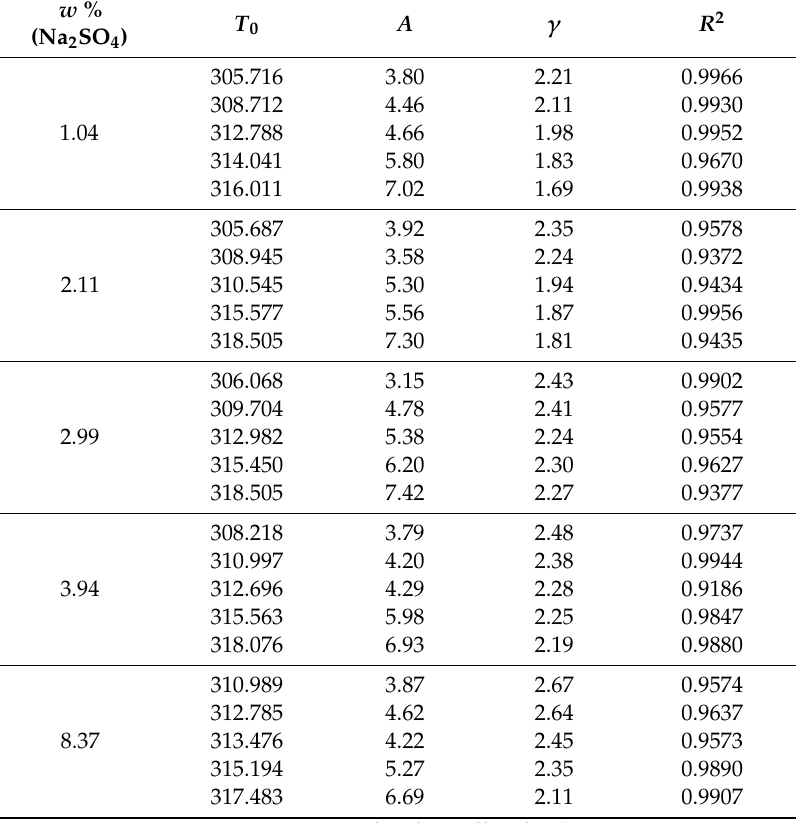
Table 4. Estimated kinetic parameter values using classical 3D nucleation theory in di ff erent concentrations of Na 2 SO 4 in the Na 2 SO 4 -NaCl-Na 2 CO 3 -Na 2 B 4 O 7 -H 2 O